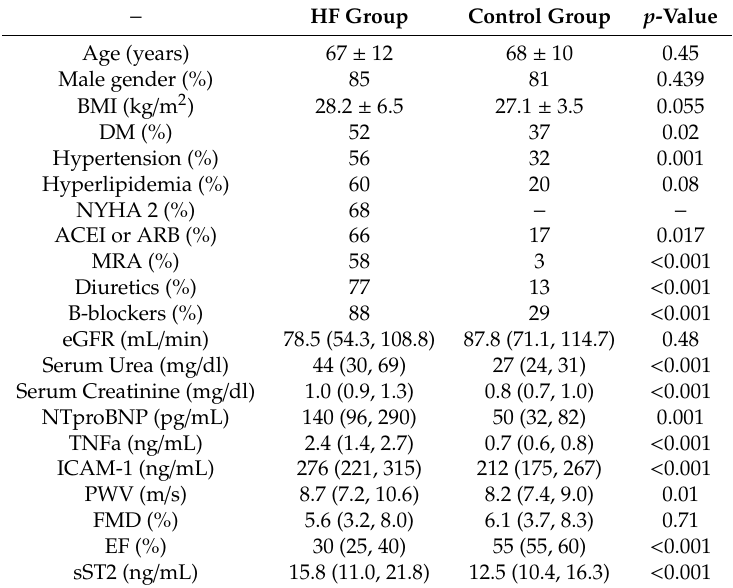
Table 1. Study participants’ demographic, clinical, and laboratory